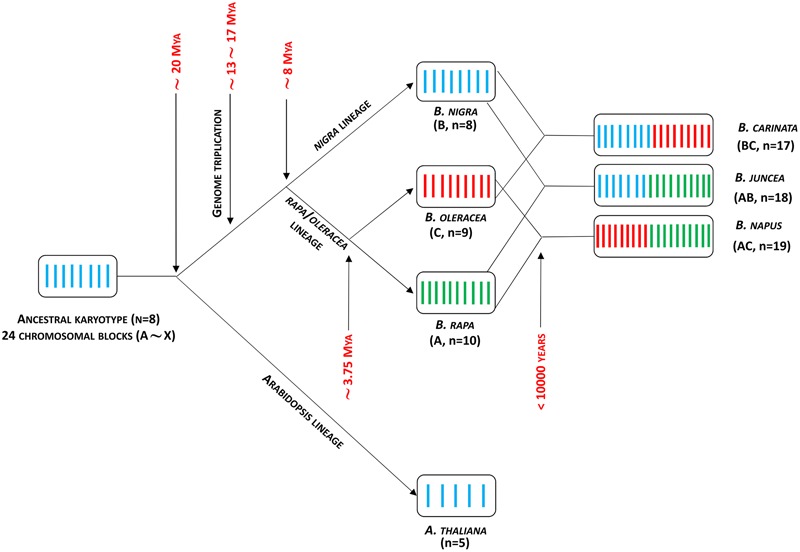
Brassica genome evolution model. Adapted from Liu et al. (2014). Mya, million years ago.